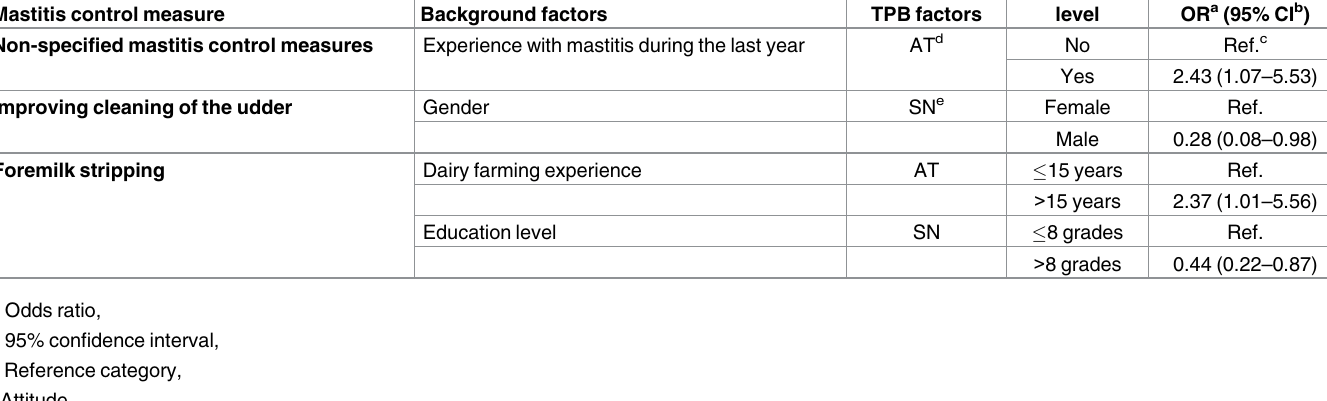
Table 6. Social and informational background factors significantly associated (P < 0.10)with dairy farmers’ (n = 134) attitude and subjective norms that were significantly associated with intentions to implement mastitis control measures based on 134 farmersin North-Western